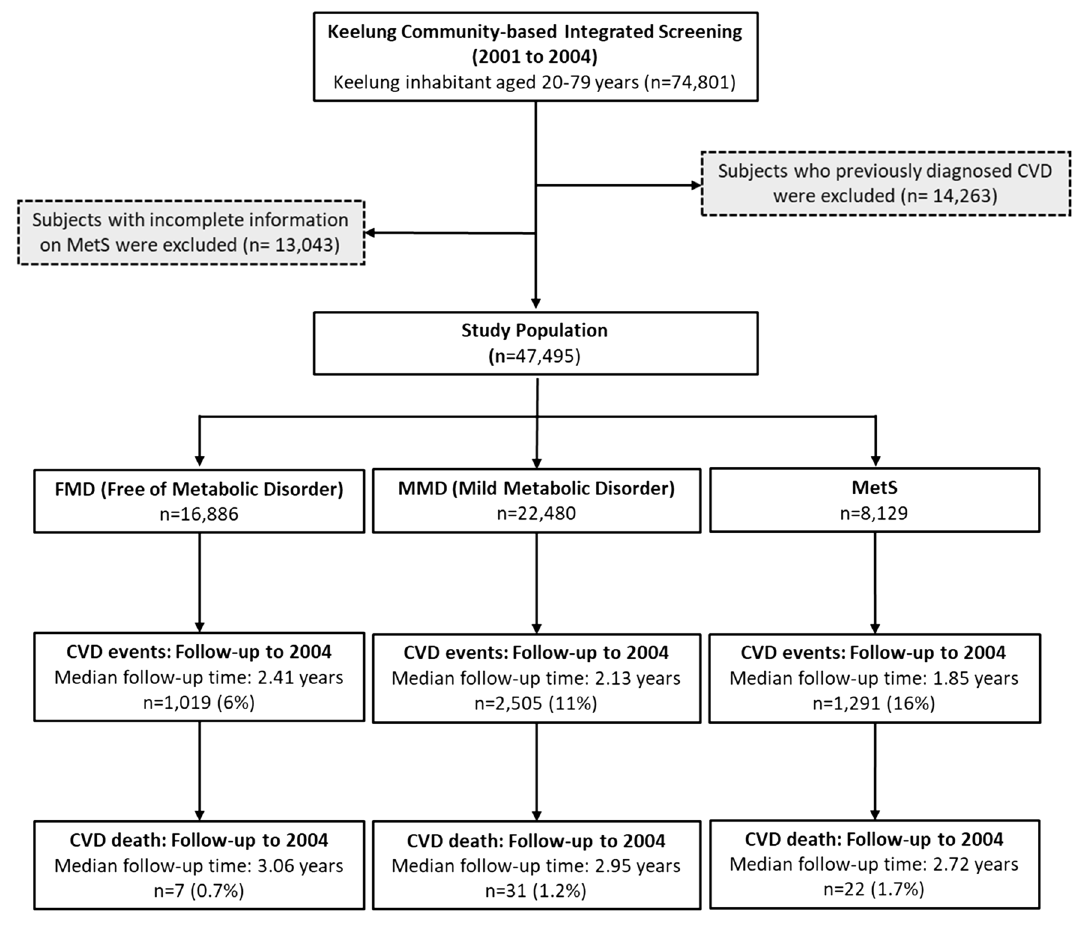
Figure 1. Flow chart of Study